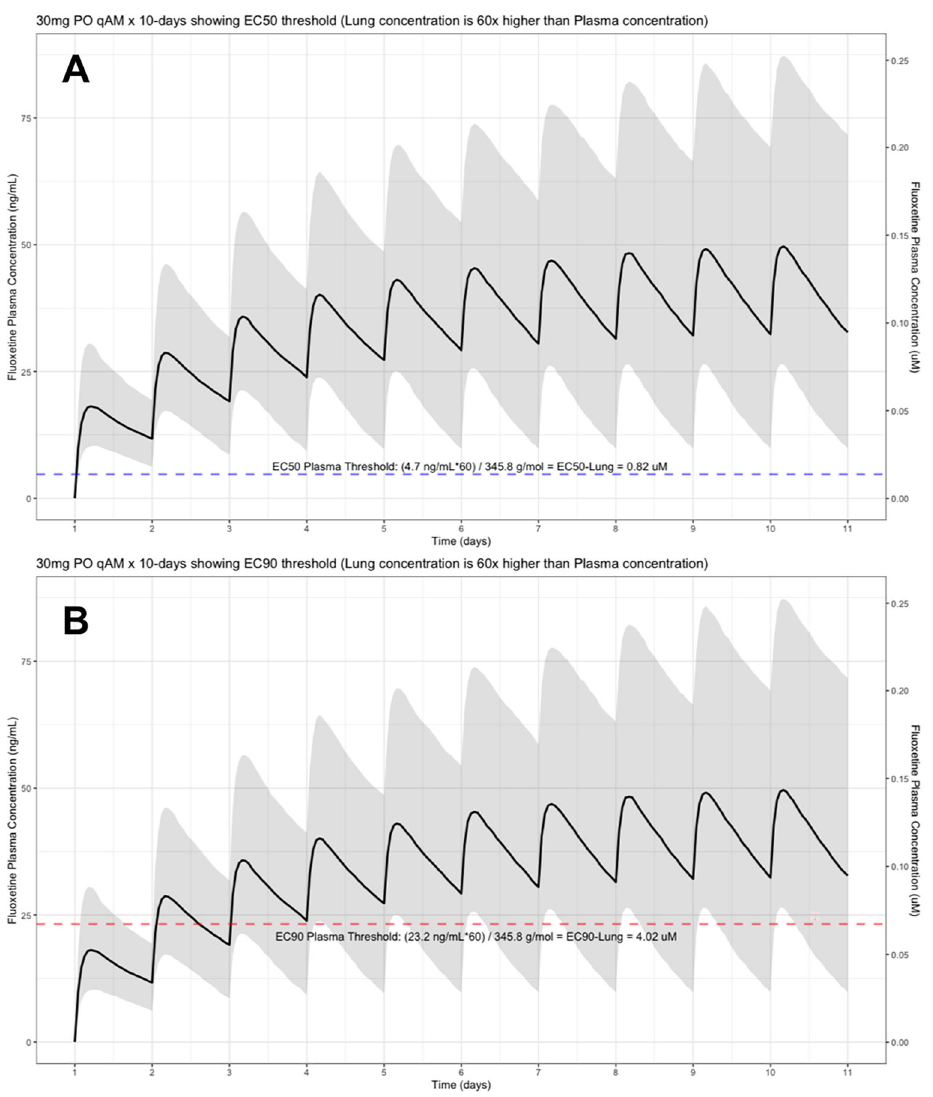
Figure 2. Fluoxetine population (n=1,000) dosing simulation results for an oral dose of 30 mg/day for 10 days. The shaded regions illustrate the 10th (lower) and 90th (upper) percentiles with the solid line within the shaded region representing the median fluoxetine concentration. The dashed horizontal line depicts the effective concen- tration resulting (A) 50% and (B) 90% inhibition (EC90) of SARS-CoV-2 that will result in 60-times higher level in the